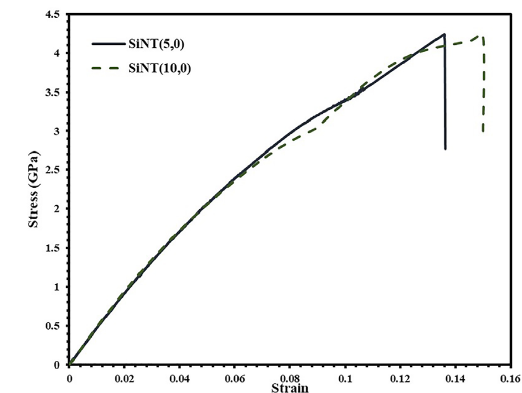
Figure 4. Stress–Strain curve of silicon nanotube zigzag (5,0) and